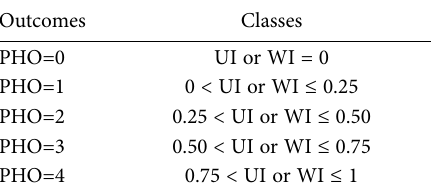
Table 1. Definition of the classes of PHO.